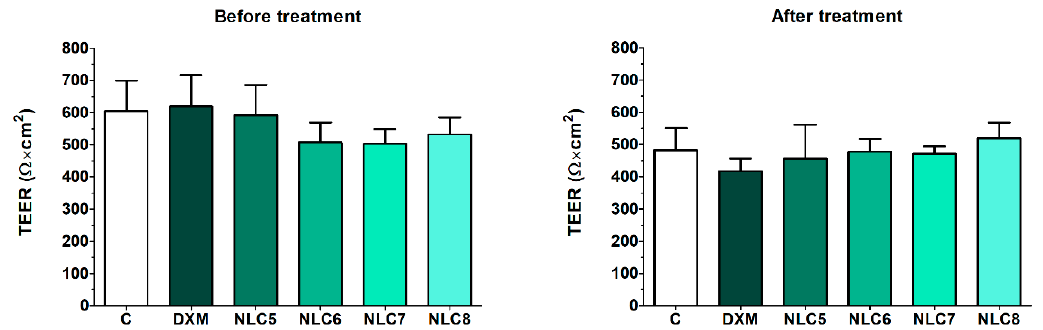
Figure 11. Transepithelial electrical resistance (TEER) values of HCE-T cell layers before and after the permeability experiment. Values are presented as means ± SD, n = 4/group. Statistical analysis: 2-way ANOVA followed by the Bonferroni test.